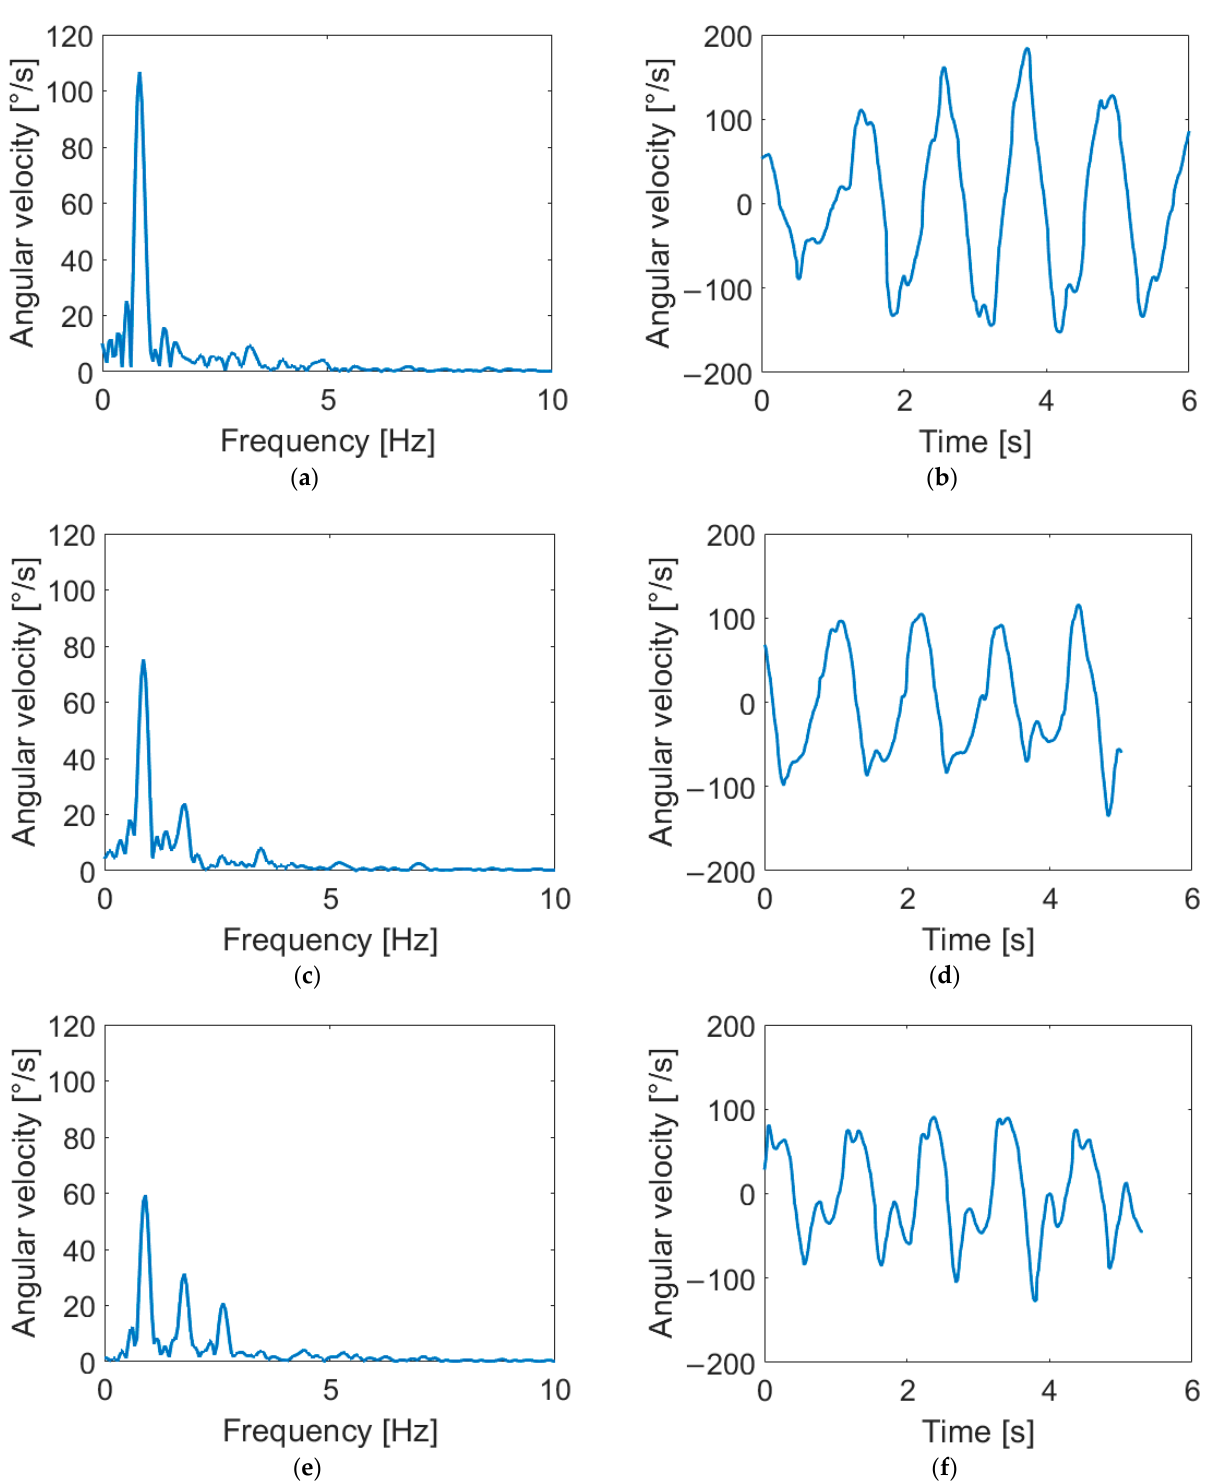
Figure 5. Arm-swing signals in frequency and time domains for different harmonic content. Signals reported show negligible distortion ( a , b ), second-harmonic distortion ( c , d ) and third-harmonic distortion ( e , f ). As shown in the figure, the second harmonic corresponds to a flattening of negative peaks in the time domain, while the third harmonic causes a flattening of both positive and negative peaks.